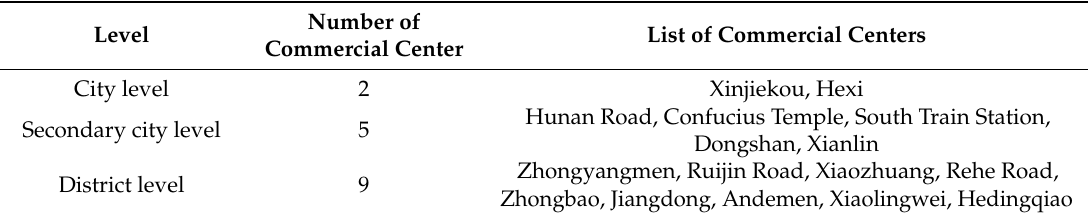
Table 3. Commercial centers in